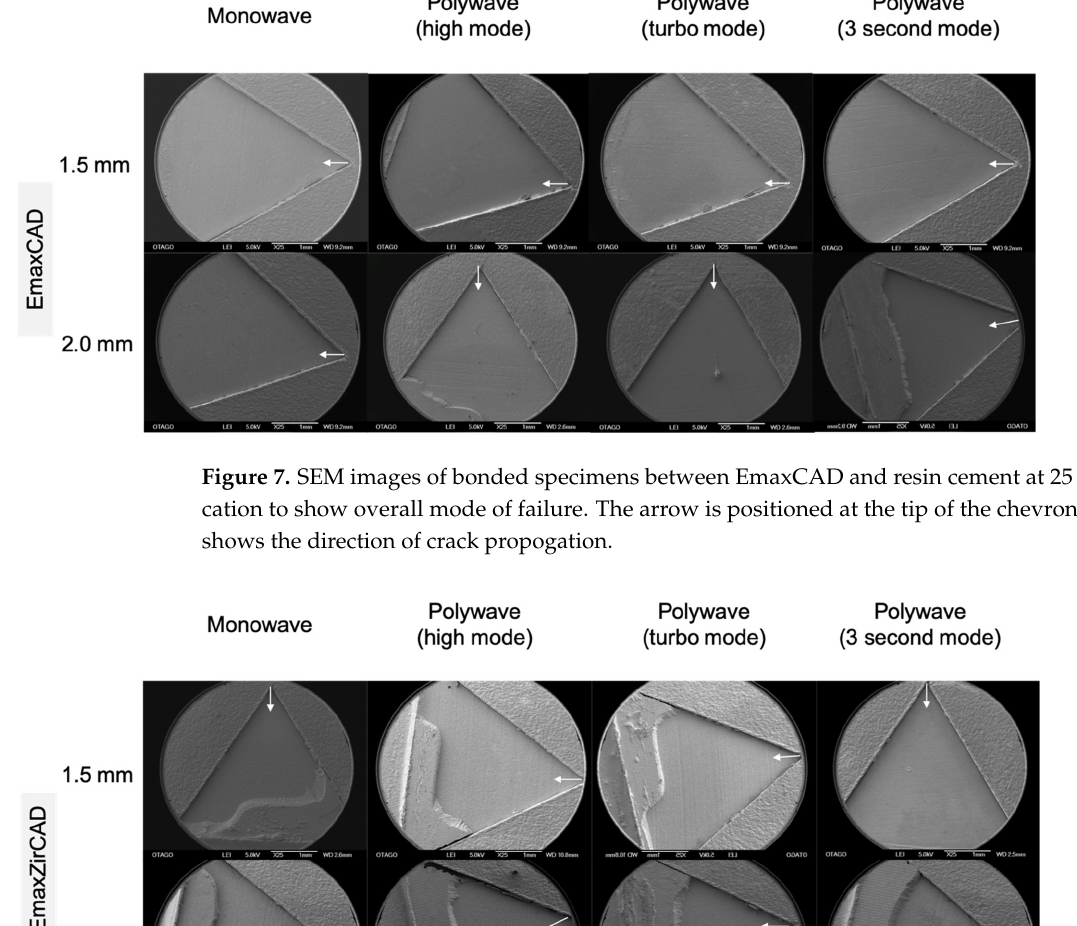
Figure 6. SEM images of bonded specimens between Empress and resin cement at 25 x magnifica- tion to show overall mode of failure. The arrow is positioned at the tip of the chevron notch and shows the direction of crack propagation.